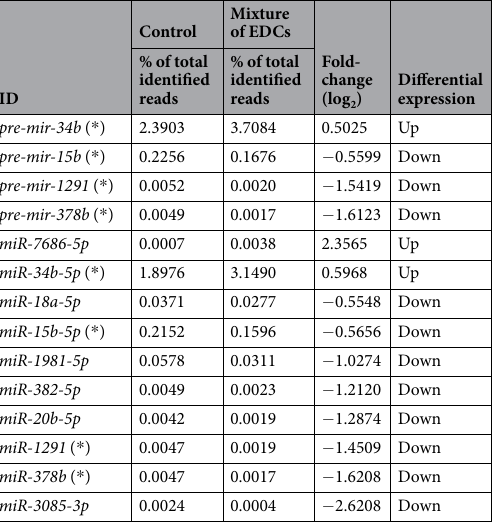
Table 2. List of miRNA populations differentially expressed after EDCs exposure. Table shows differentially expressed testicular precursors and canonical miRNAs in control and chronically exposed animals to the mixture of EDCs. ( * ) The asterisk indicates increase or decrease in both the precursor and the mature form of the miRNA. RNA libraries of pools of mice testes, fold change (log 2 ). Data normalised using the DeSeq tool of the R/Bioconductor software package, n = 3, * p ≤ 0.05.